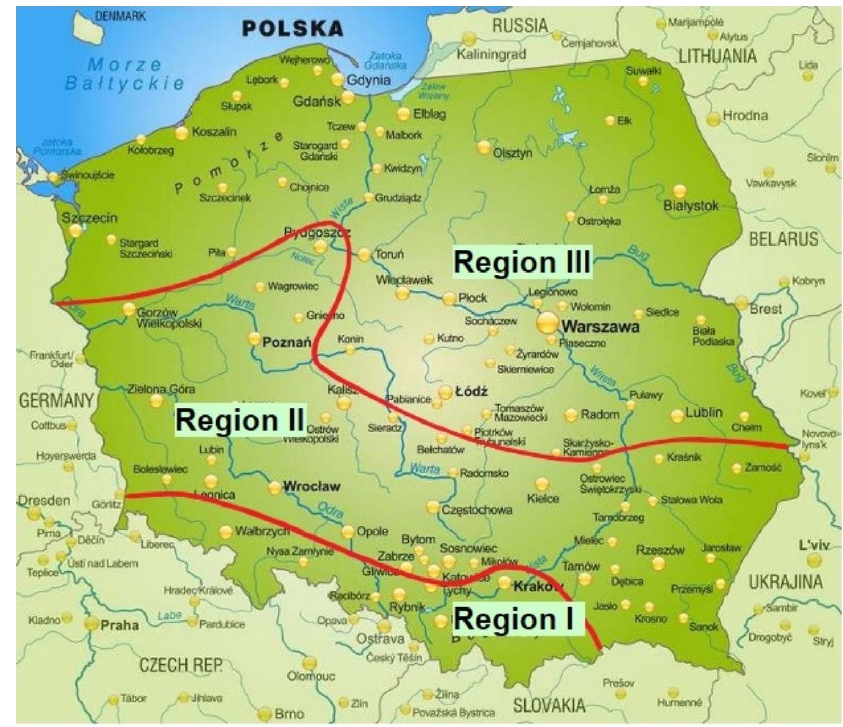
Figure 1. “Smoggy” areas with higher PM concentrations in air in Poland [31]. Region I —smog incidents occur frequently and last the longest; Region II —smog incidents occur with lower frequency; Region III —smog incidents occur rarely.